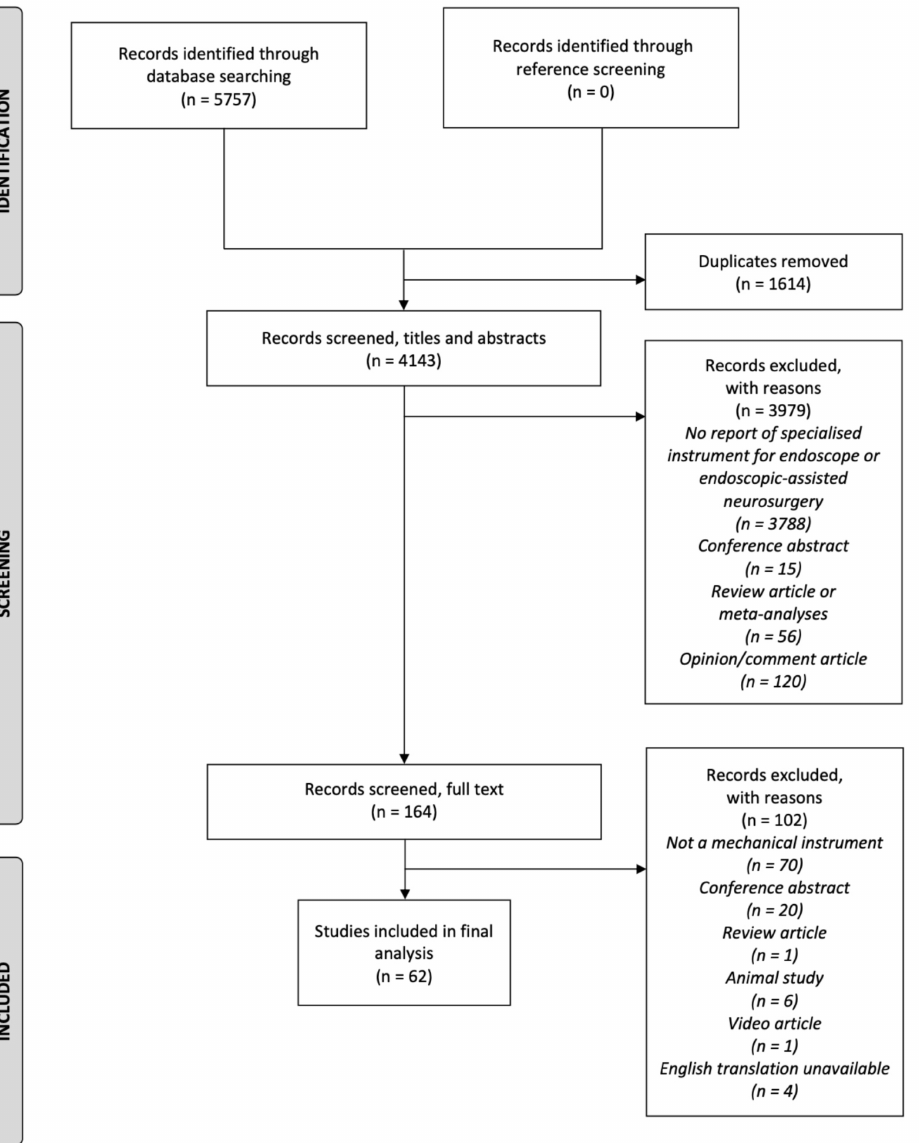
Figure 1. PRISMA flow diagram of the inclusion and exclusion of